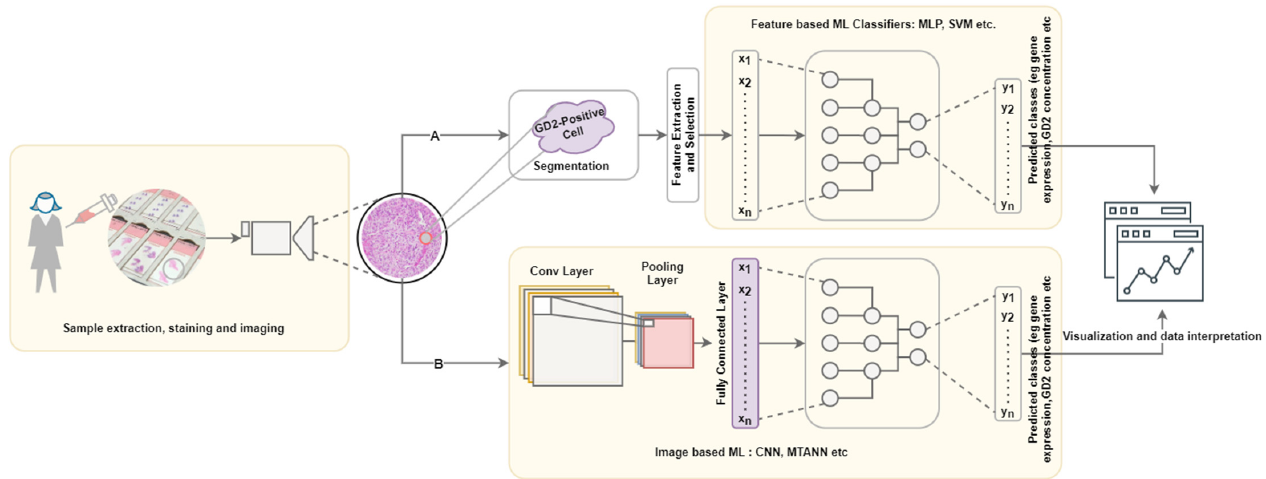
Figure 2. Pipeline for GD2-positive tissue/cell characterization; Path A represents feature-based ML, which is dependent on the effective of the chosen segmentation algorithm. Path B represents the image-based approach, which may only involve minimal preprocessing steps such as tiling. Image adapted from [93].